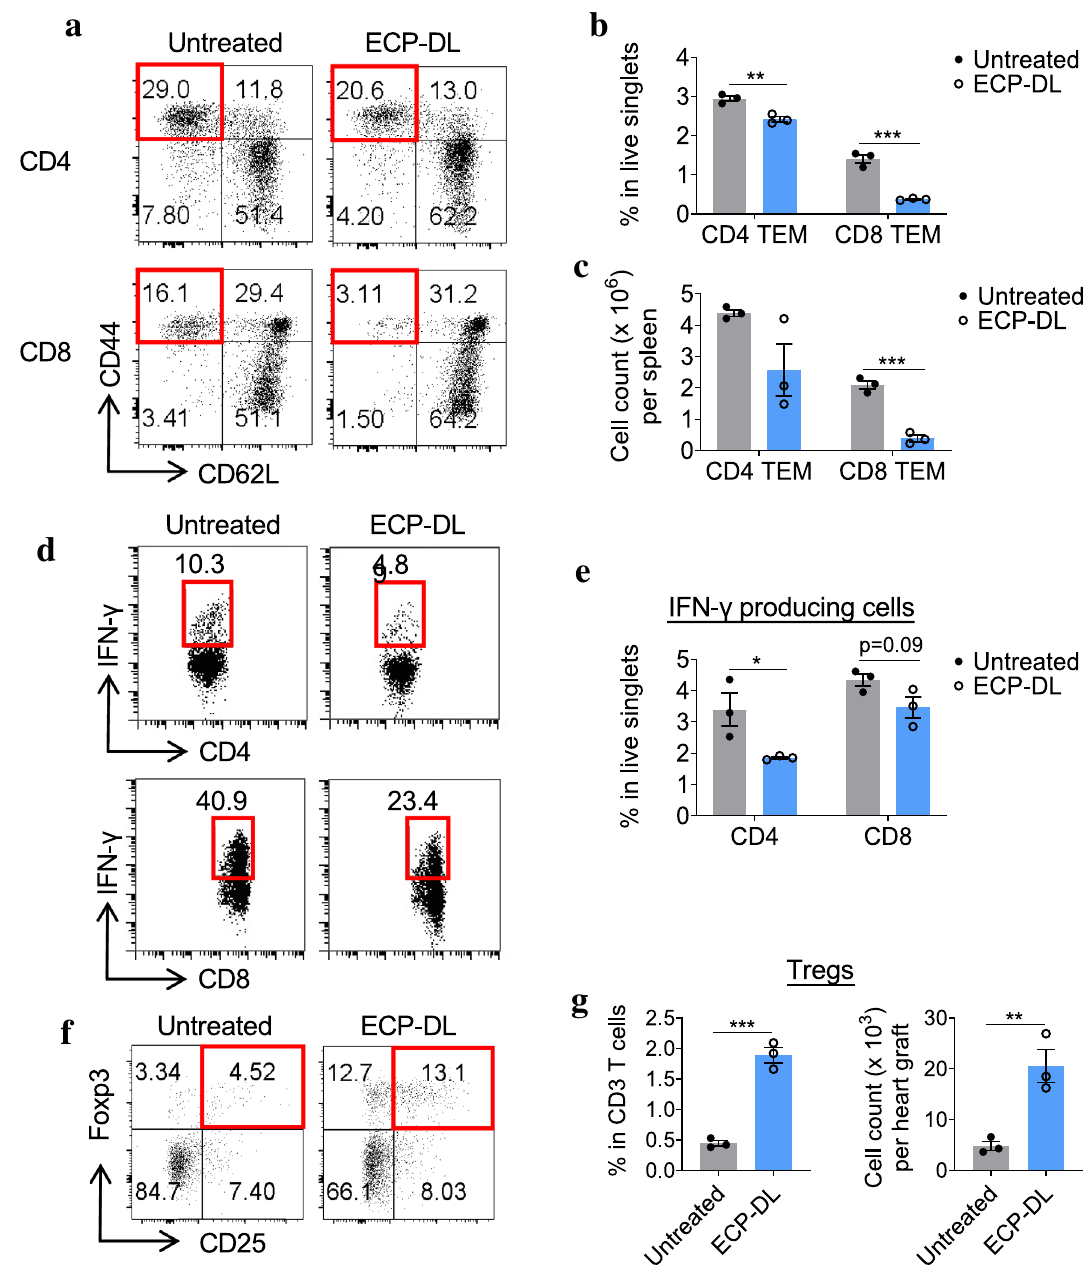
Figure 2. ECP-DL infusion inhibits effector memory T-cells and Th1 response after cardiac transplantation. ECP-DL treated or untreated controls were euthanized on POD7; spleens and heart grafts were harvested for flow cytometry analysis (n = 3 per group). ( a-c ) Representative dot plots and bar graphs showing that in ECP- treated mice, both CD4 + and CD8 + effector memory T-cells (TEM, CD44 + CD62L - ) were decreased compared with that of the untreated group. ( d, e ) The frequency of interferon-gamma-producing CD4 + and CD8 + T-cells was significantly decreased in the ECP-treated mice, demonstrating a reduced Th1 response. ( f, g ) Tregs, identified as CD25 + /Foxp3 + (gated from CD3 + CD4 + cells) were significantly higher in the cardiac allografts of the ECP-DL group than that of the untreated group. In B , C , E , and G , * p < 0.05, ** p < 0.01, *** p < 0.001 by student t lized an established 2C and 4C transgenic mouse model to evaluate the antigen-specific effects of ECP therapy on alloreactive T-cells prior to transplantation 27 . CD-4C and CD8-2C T-cells were isolated from TCR transgenic B6 mice and labeled with carboxyfluorescein succinimidyl ester (CFSE) to evaluate lymphocyte proliferation rates. CD4-4C and CD8-2C T-cells recognize epitopes presented by donor MHC class II or I molecules, respec- tively. Labeled T-cells from transgenic B6 mice were injected into standard B6 mice on day 0. On day 1, spleno- cytes from standard BALB/c mice were isolated as in prior experiments and were injected into the B6 recipient;